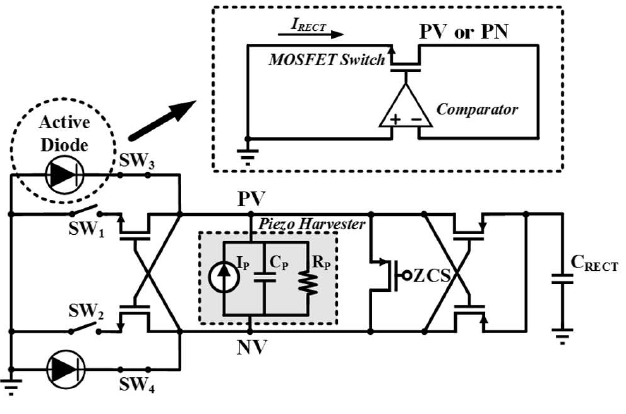
Figure 16. Dual-mode rectifier for PE transducer proposed in [46]. Reproduced with permission from M. Shim, IEEE Journal of Solid-State Circuits; published by IEEE,